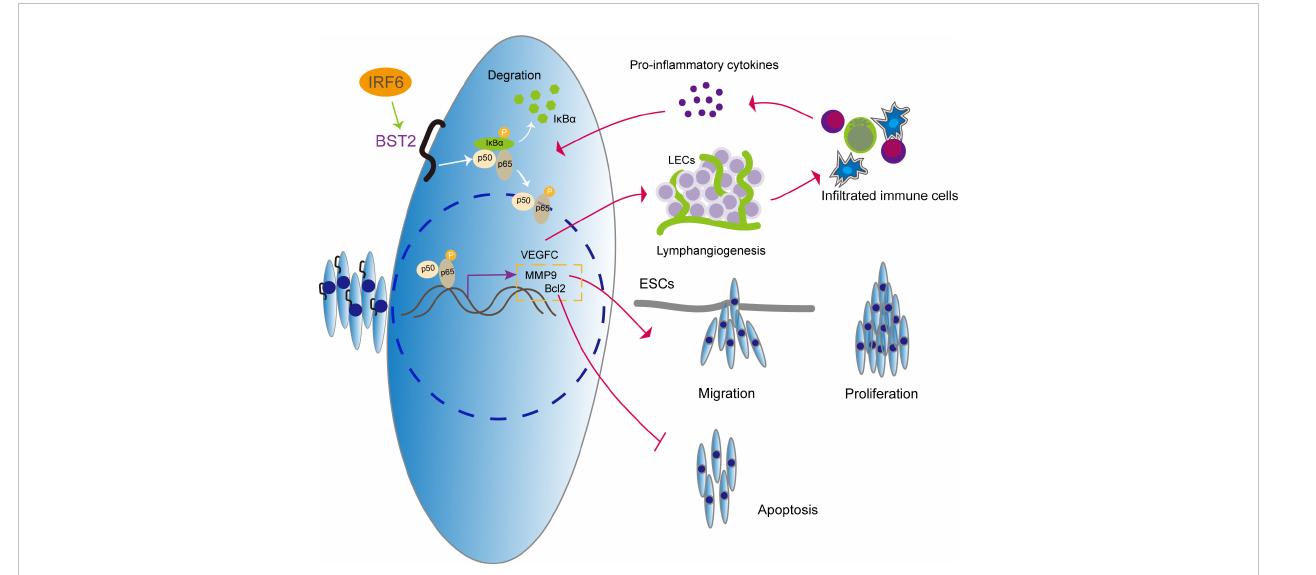
FIGURE 13 The illustrative model of BST2 in the development of